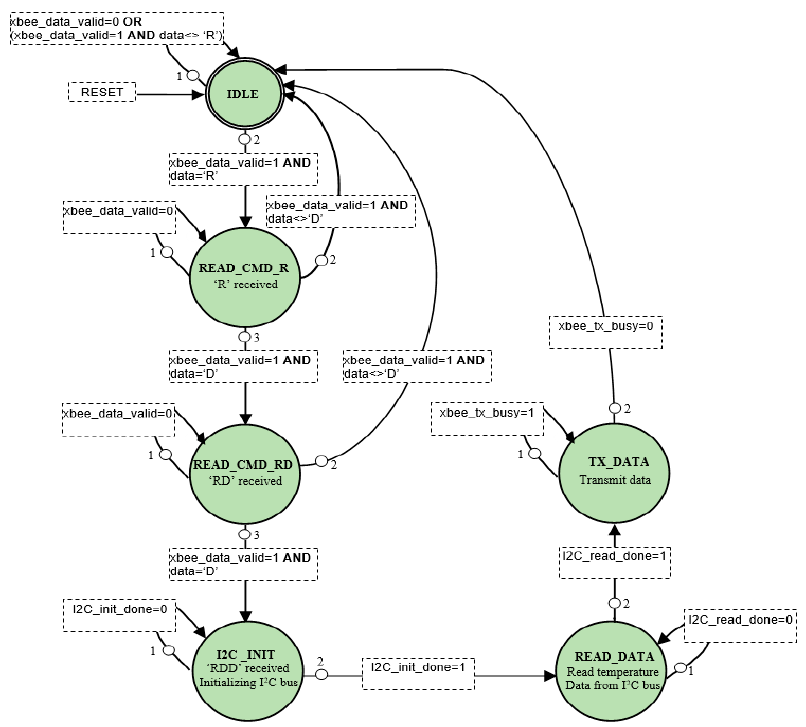
Figure 6. State diagram of I2C temperature-sensing logic.